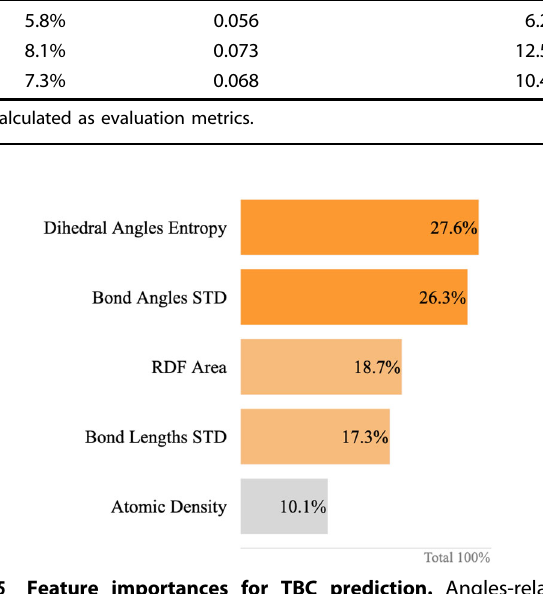
Fig. 5 Feature importances for TBC prediction. Angles-related features are the most predictive. Atomic density is the weakest predictor but still relevant.